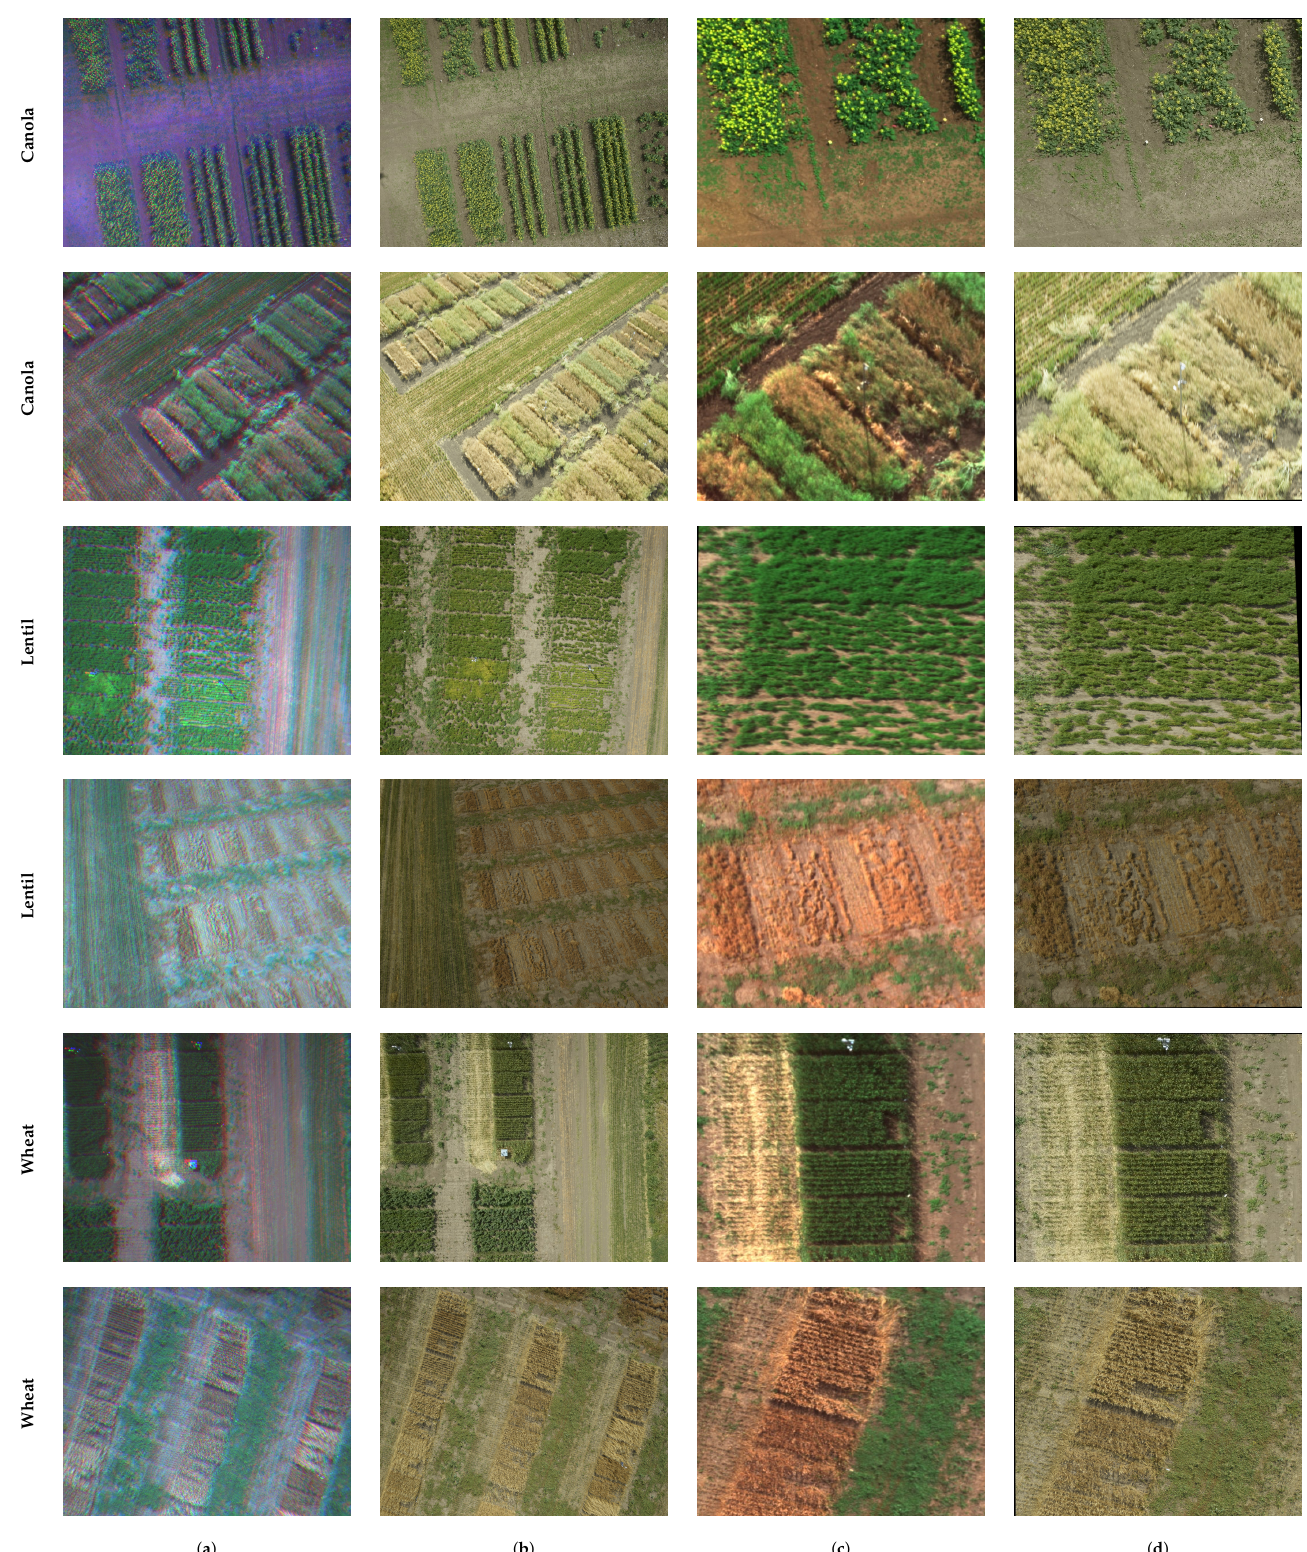
Figure 3. Example images from our canola (top two rows), lentil (middle two rows), and wheat (bottom two rows) datasets, showing: ( a ) unaligned raw LR image, ( b ) the matched raw HR image, ( c ) radiometrically calibrated and aligned LR cropped patch, ( d ) the corresponding aligned HR cropped patch. The LR images are 8